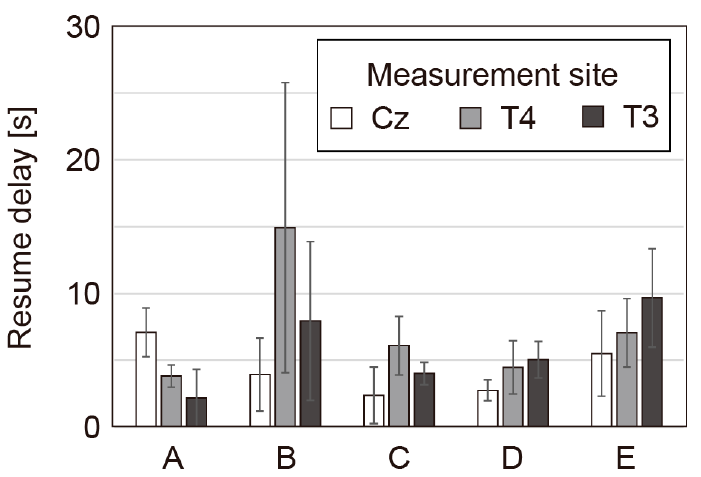
Figure 9. Time required to resume measurement after detachment for various measurement sites.